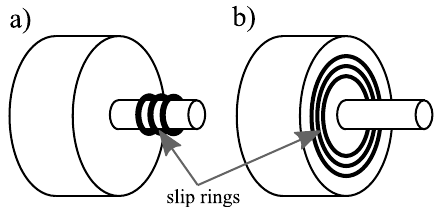
Figure 10. Three phase slip rings configuration: ( a ) typical machine, ( b ) concentric slip ring configuration used in prototype generator.